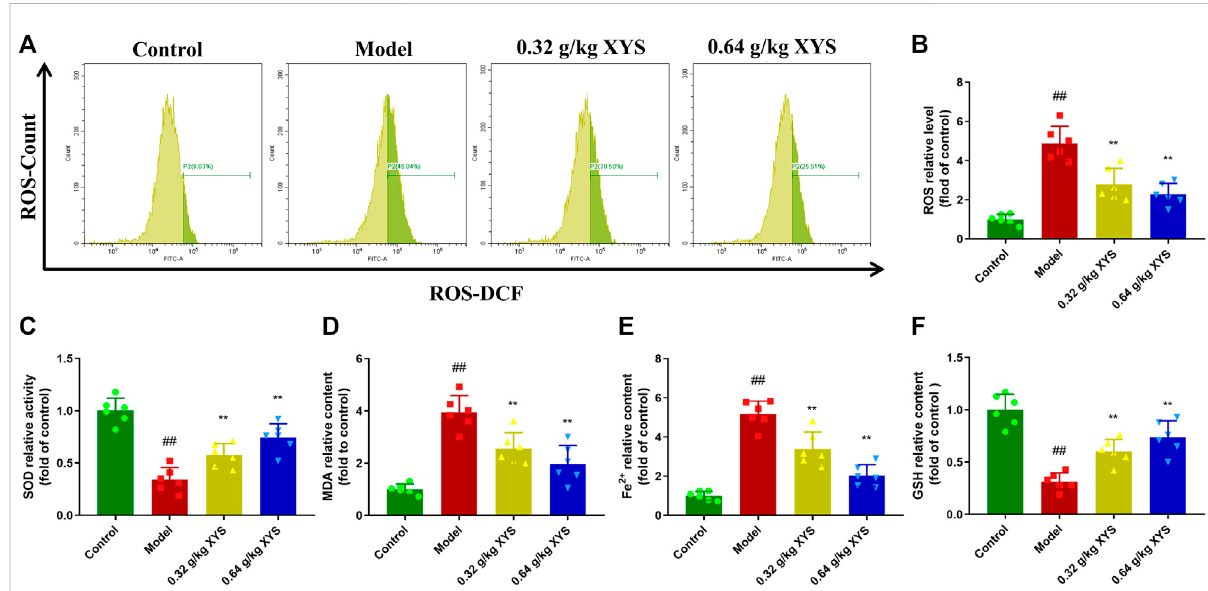
FIGURE 4 The oxidative stress level and Fe 2+ production in liver tissues in each group. Mice were treated with XYS (0.32 or 0.64 g/kg) via gavage for three consecutive days and sacri fi ced on the fourth day. (A) The ROS level of cells from liver tissue homogenates in each group was detected using fl ow cytometry with aDCFH-DAprobe. (B) The relativelevel ofROS ineachgroup, and eachbarrepresentsthemeanlevel ofROS inlivertissues ±SD. (C) TherelativelevelofSODineachgroup,andeachbarrepresentsthemeanlevel ofSOD inlivertissues±SD. (D) TherelativelevelofMDAineach group,andeachbarrepresentsthemeanlevelofMDAinlivertissues±SD. (E) TherelativecontentofFe 2+ ineachgroup,andeachbarrepresentsthe mean content of Fe 2+ in liver tissues ±SD. (F) The relative level of GSH in each group, and each bar represents the mean level of GSH in liver tissues ±SD. # p < 0.05 vs. Control group, and ## p < 0.01 vs. Control group; p p < 0.05 vs. Model group and pp p < 0.01 vs. Model